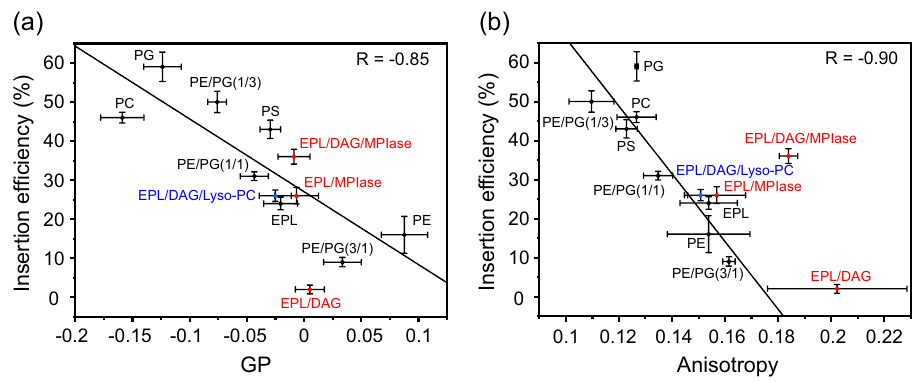
Figure 4. Correlation between membrane insertion efficiency values (Tables 2 and S1) and Laurdan GP values at 37 °C, GP = ( I 440 − I 490 )/( I 440 + I 490 ) , calculated from the emission spectra (Fig. S8) ( a ), and membrane insertion efficiency values and fluorescence anisotropy values of DPH at 37 °C (Fig. S9) ( b ) in the various types of membranes. LUVs that are composed of bulk membrane phospholipids are represented by black circles in each figure, whereas red circles represent the LUVs including DAG and/or MPIase. Blue circles represent the LUVs including Lyso-PC. Global linear fits were performed for the bulk phospholipids shown in